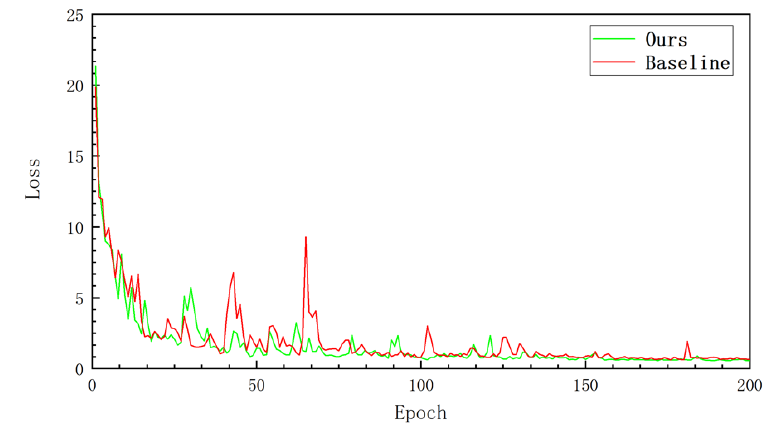
Figure 11. Network training loss curve.